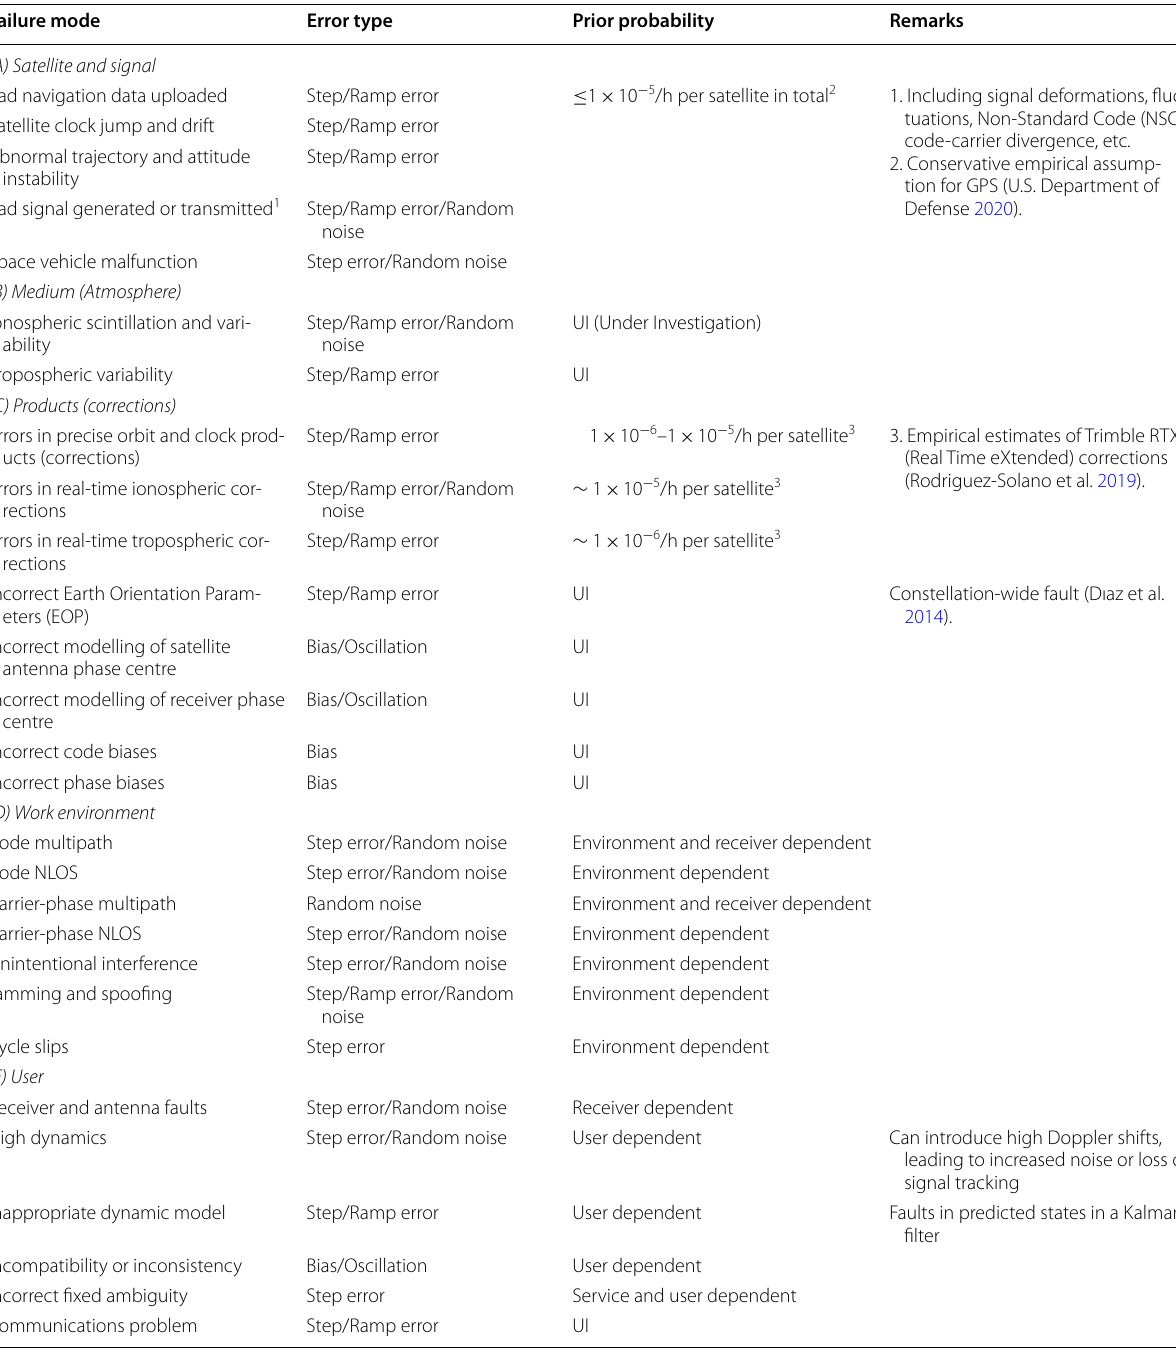
Table 1 Compiled failure modes of GNSS PPP Failure mode Error